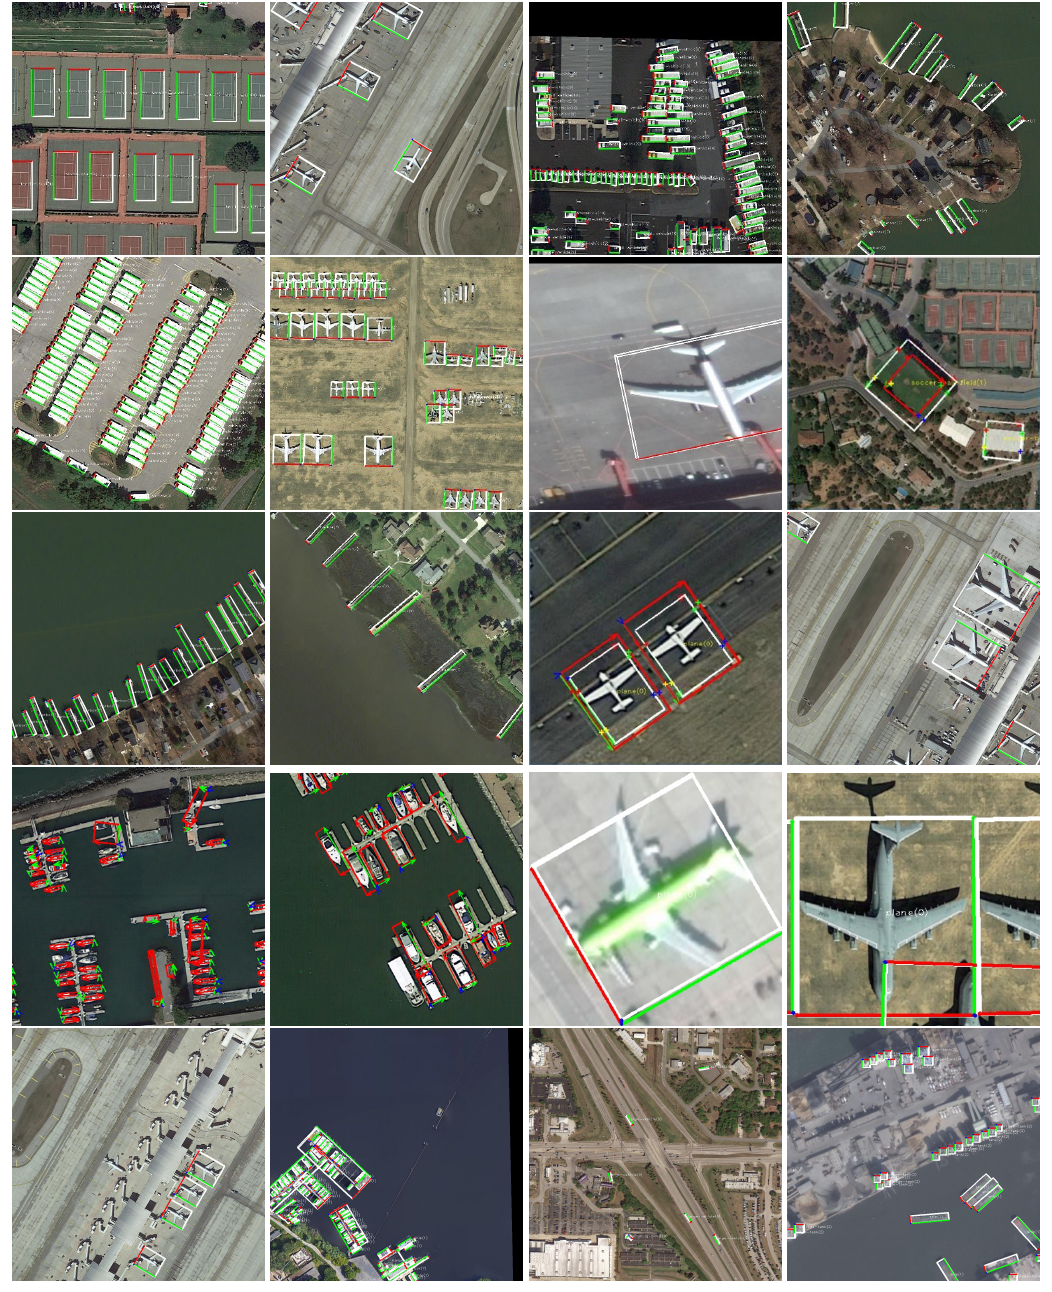
Figure 9. 3D pose renderings. The red arrow direction and the green arrow direction in the figure are the X-axis and Y-axis of the object itself,